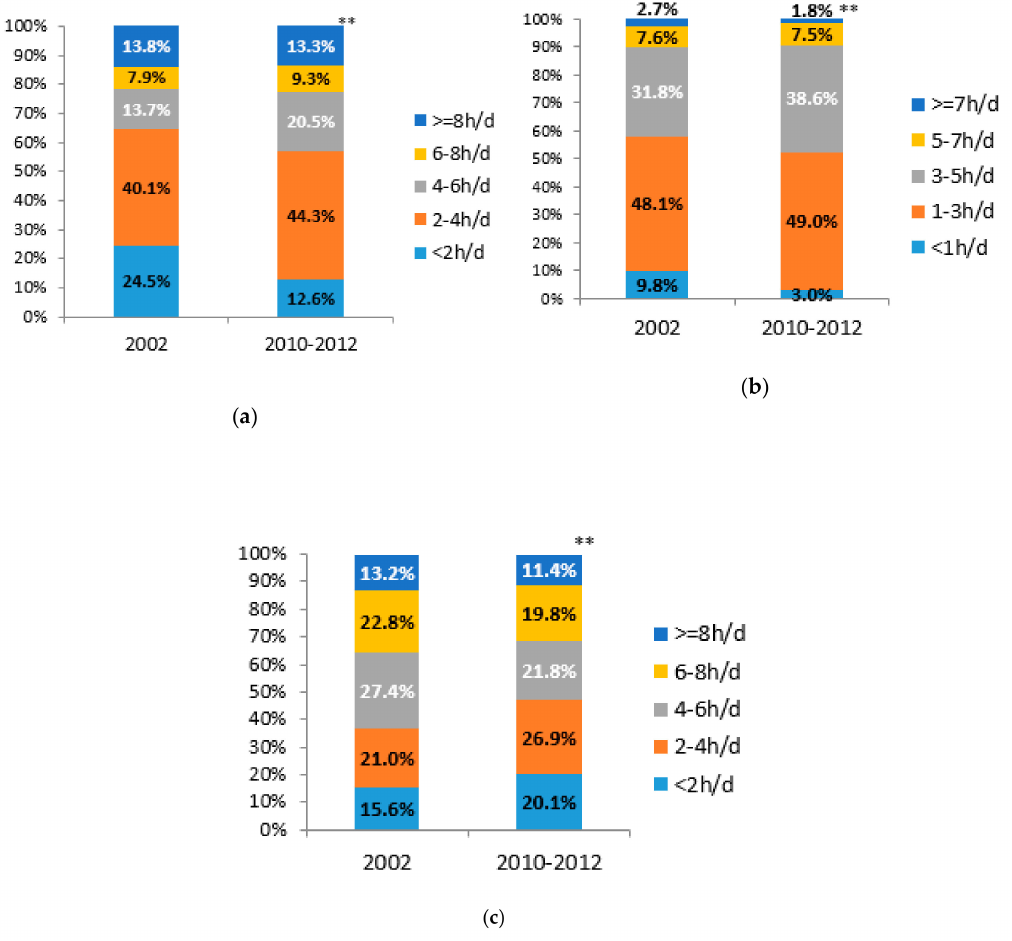
Figure 3. Changes § in distribution of SB time among Chinese adults from 2002 to 2010–2012 (%): ( a ) changes in total SB time; ( b ) changes in leisure SB time; ( c ) changes in occupational SB time # ( § gender and age standardized to the 2010 China census population; # Time of occupational SB was only calculated in employed participants, n 2002 = 126,25, n 2010–2012 = 31,914; ** p < 0.001, significance is based on Chi–square